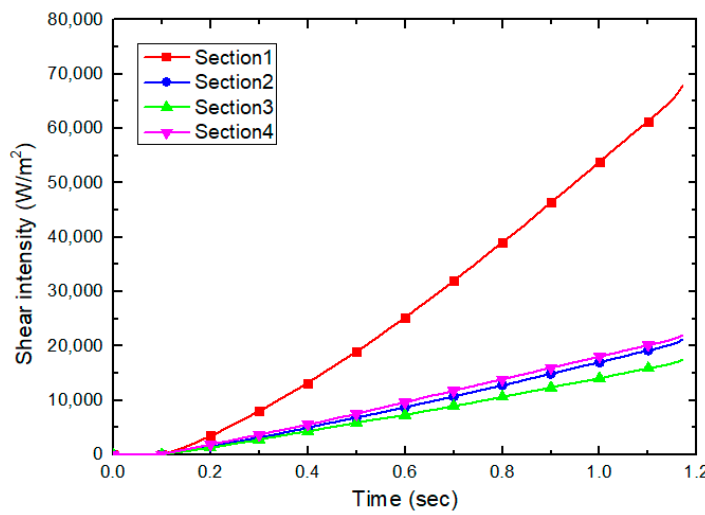
Figure 22. History of average cumulative shear work.